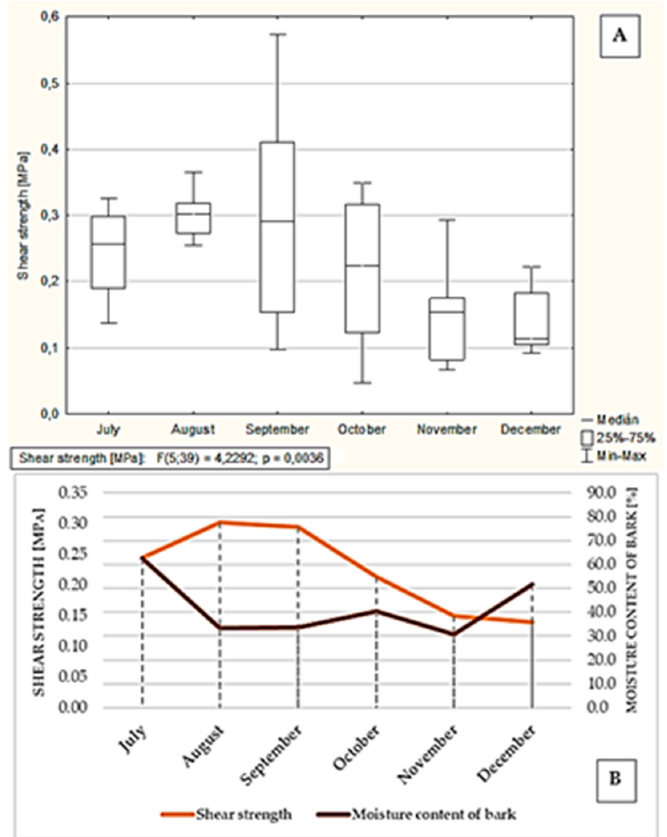
Figure 8. ( A ) The values of the shear strength at monthly intervals and ( B ) the effect of the moisture content of bark on the shear strength of the wood/bark of oak logs.